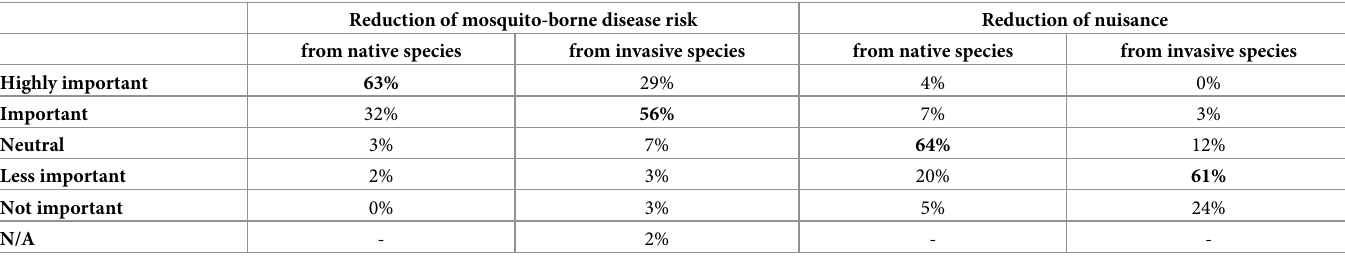
Table 4. Rating of the objectives of mosquito control programs based on the answers of 59 experts. Reduction of mosquito-borne disease risk Reduction of